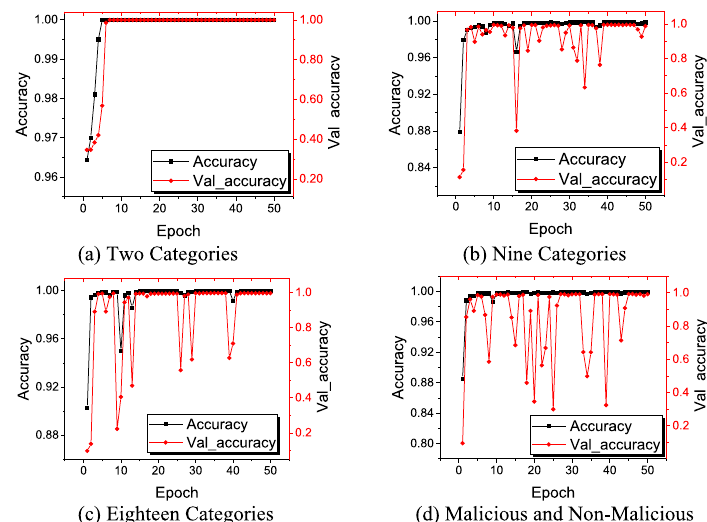
Fig. 2 HexCNN-1D Mode Experimental